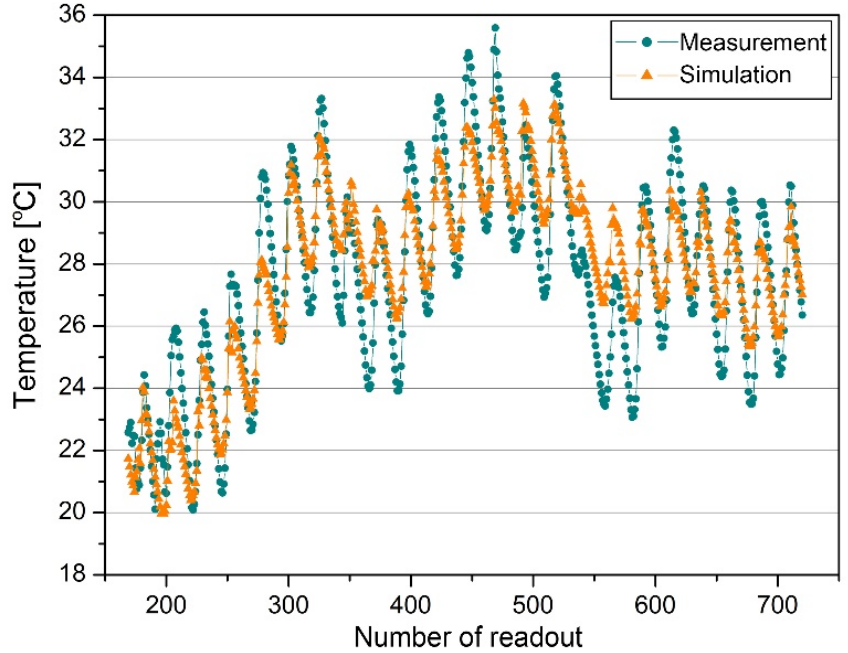
Figure 4. Climatic chambers, Rzeszów University of Technology.